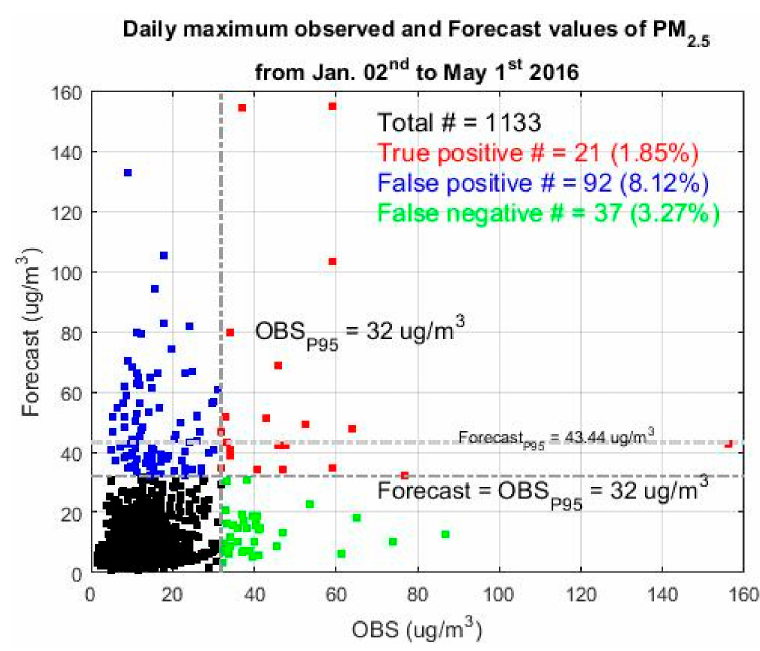
Figure 7. The 2016 burn impact forecast statistics. The thresholds for burn impacts are drawn at 32 µ g m − 3 , which is the 95th percentile of all observed maximum afternoon PM 2.5 concentrations throughout Georgia between 2 January and 1 May